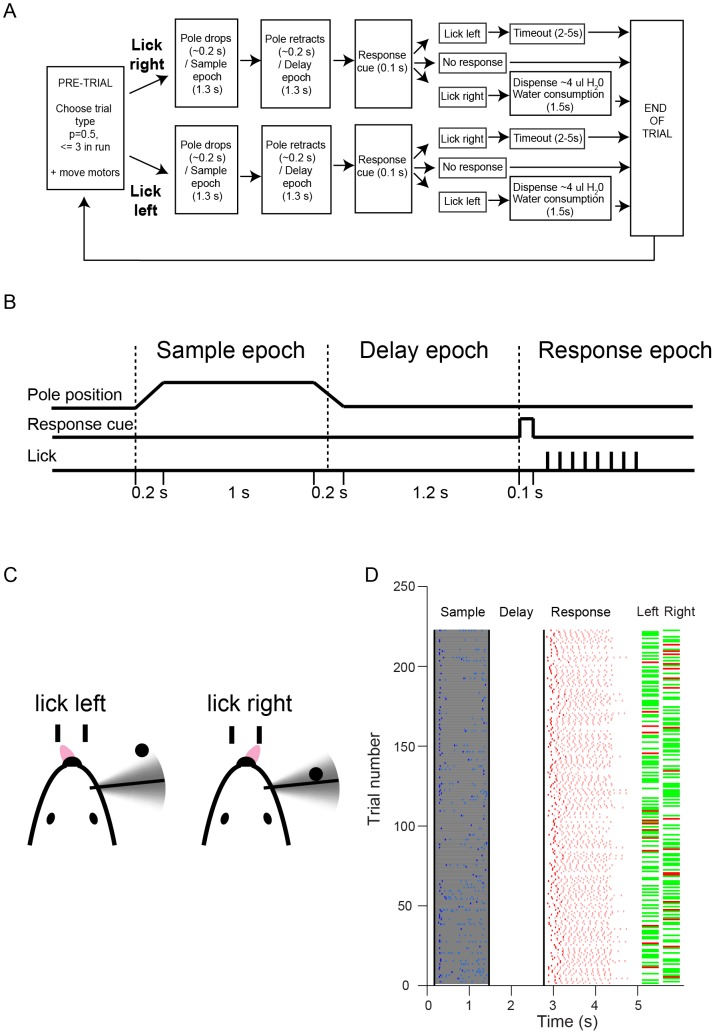
A lick-left/lick-right object location discrimination task with a delay epoch [7].A. Block-diagram showing the possible events in a single trial. Licking during the sample or delay epochs leads to a brief timeout (1–1.2 s) and were not shown for clarity. B. Schematic of event timing during a single trial. Same as Figure 1C of [7]. C. Schematic representation of the behavioral contingency. Mice had to touch a left lickport for a water reward for an anterior pole location and a right lickport for a posterior pole location. In some experiments the contingency of the pole positions was reversed. D. Behavioral data from one session. Trials with the licking response before the response cue were excluded for clarity (25% of total trials). The abscissa shows the time from trial start. Lick-left and lick-right trials are randomly interleaved. The blue and light blue ticks indicate the onset time of the first and subsequent contacts respectively. The red and pink ticks indicate the first and subsequent licks respectively. The horizontal green and red bars indicate whether each trial is correct or incorrect respectively. The dark gray shading indicates the sample epoch during which the pole is within reach of the whiskers. The black vertical lines delineate the sample, delay and response epochs.